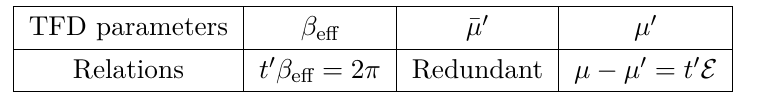
Table 2 . A summary of relations between the TFD parameters, IR parameters and parameters in the Hamiltonian